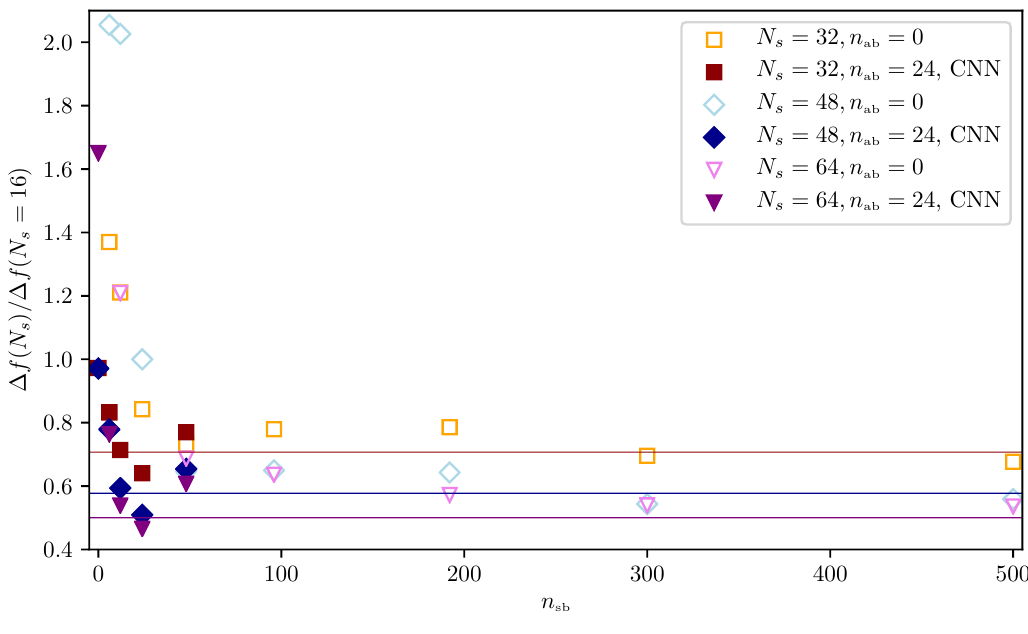
Figure 8 . Error ∆ f of the free-energy density for N s × 8 lattices normalized to the error for a 16 × 8 lattice, for different flows at κ = 0 . 2 , λ = 0 . 022 and with N meas = 2 × 10 5 . Horizontal lines show the error decrease that is expected considering only the volume